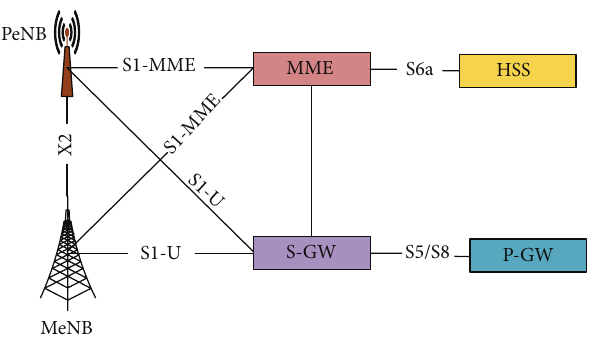
Figure 3: Deployment of the MeNB-PeNB architecture